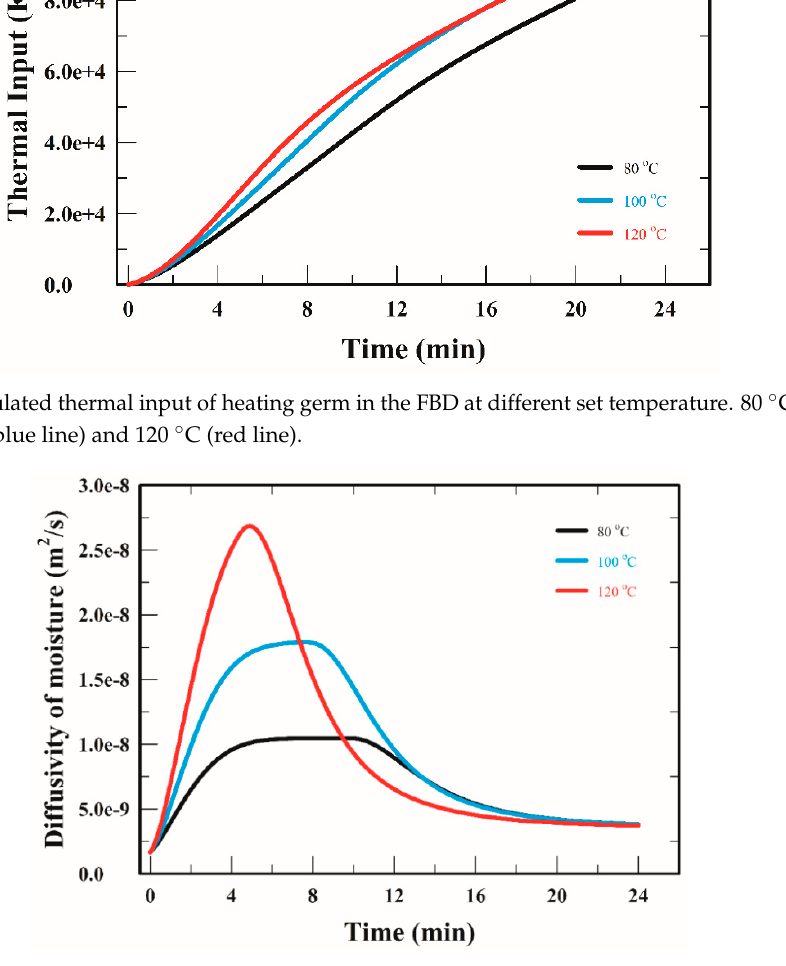
Figure 8. Simulated profiles of the diffusivity of water vapor inside WG during drying in the FBD. 80 °C (black line), 100 °C (blue line) and 120 °C (red line).